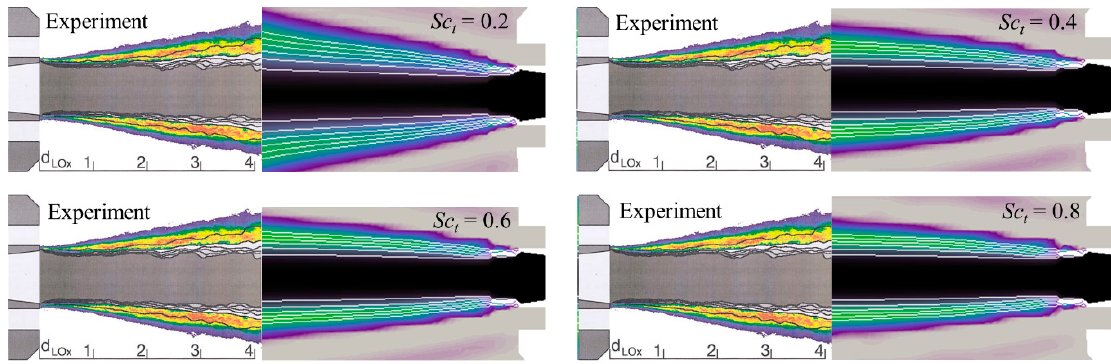
Figure 13. Contours of time-averaged jet position overlapped on normalized OH fields for experiment (left of each image) and this study (right of each image) with an increase in the turbulent Schmidt number. In the experiment image, gray core region is where jet is present continuously, and iso-value of dark gray contour line decreases from 0.875 to 0.25 of the time with interval 0.125 as the line lies outside the jet. In this study, iso-value of white contour line decreases from 0.875 to 0.25 of pure oxygen mass fraction with interval 0.125.